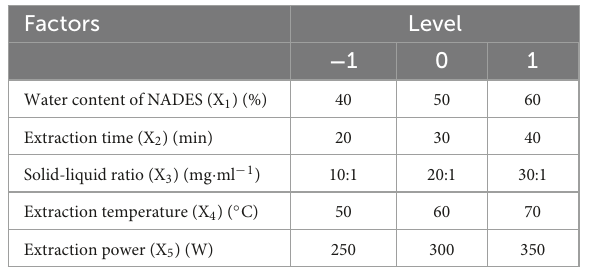
TABLE 3 Independent variables and levels used for Box-Behnken design